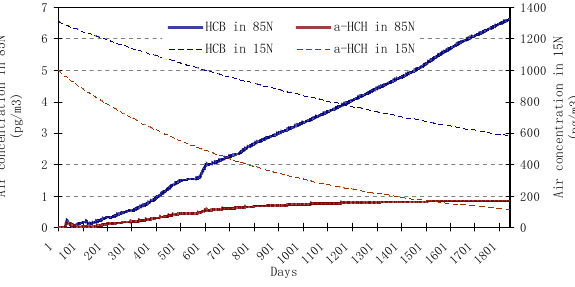
Fig. 6 Fig. 6. Modeled daily air concentration of α -HCH and HCB at the 10m height during a 5 years period in 15 ◦ N and 85 ◦ N, respec-